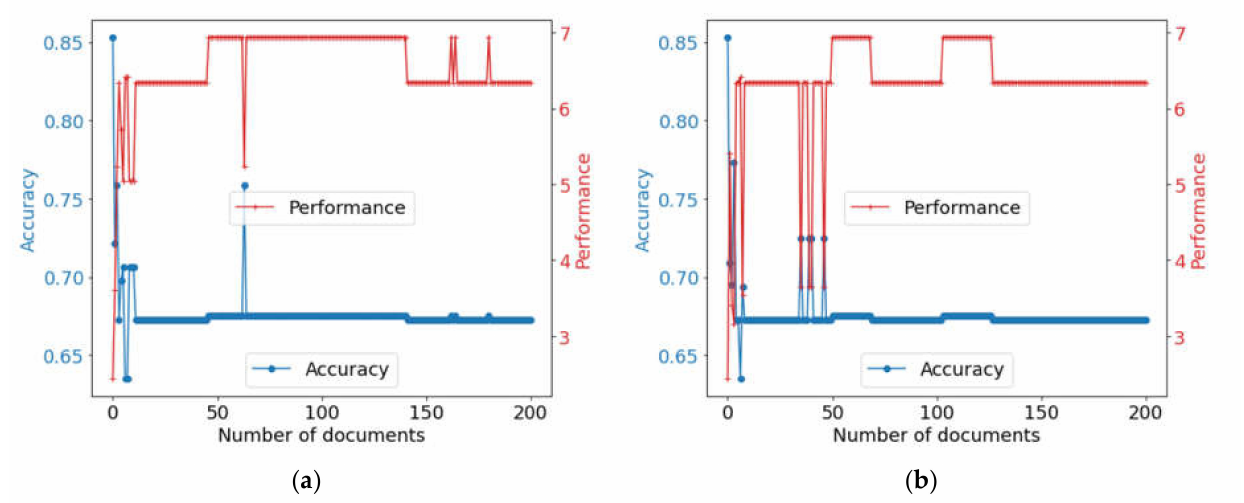
Figure 8. Case 1 auctioning results: ( a ) prioritization by accuracy, ( b ) prioritization by performance.